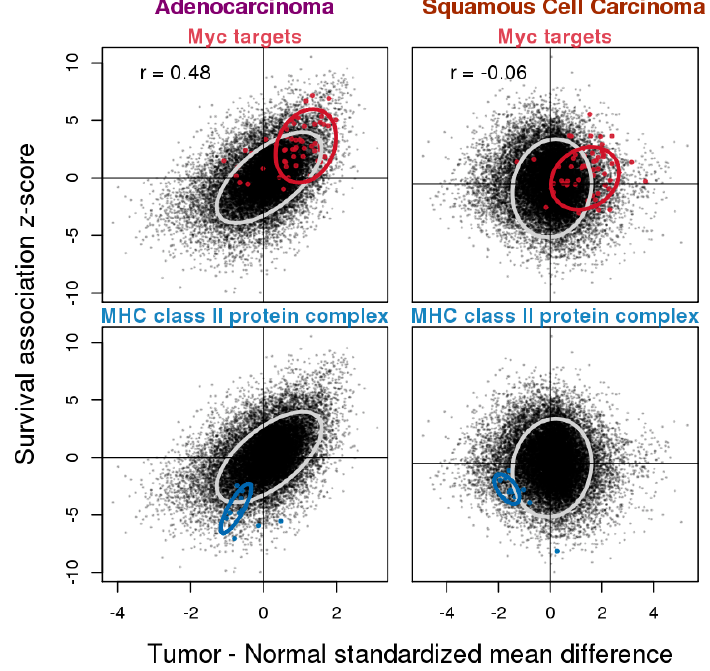
Figure 4. Relationship between tumor–normal gene expression difference and survival association in ADC and SQCC. For all genes, summary standardized tumor–normal gene expression differences from the meta-analysis were used as the x -axis values and summary z -scores from the survival association meta-analysis based on the Cox-PH model were used as the y -axis values. Results from ADC and SQCC were plotted separately. Moderately positive correlation with a Pearson correlation r = 0.48 was observed for ADC, while that of SQCC was close to 0. Selected gene sets were highlighted including the Myc targets from HALLMARK_MYC_TARGETS_V2 in the hallmark gene set collection and MHC class II protein complex components in the c5.cc GO cellular component gene set collection. Ellipsoidal boundary wraps were around the 75% highest density/minimum volume for all genes (gray) or selected genes (non-gray colors).